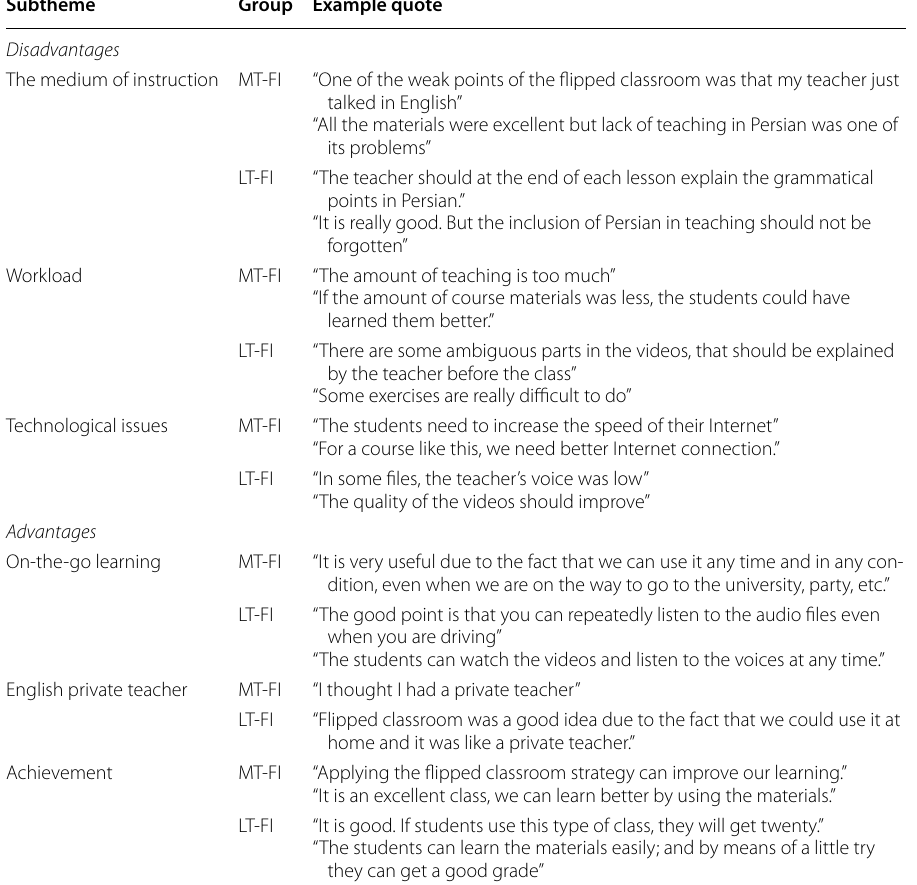
Table 10 Challenges and opportunities of